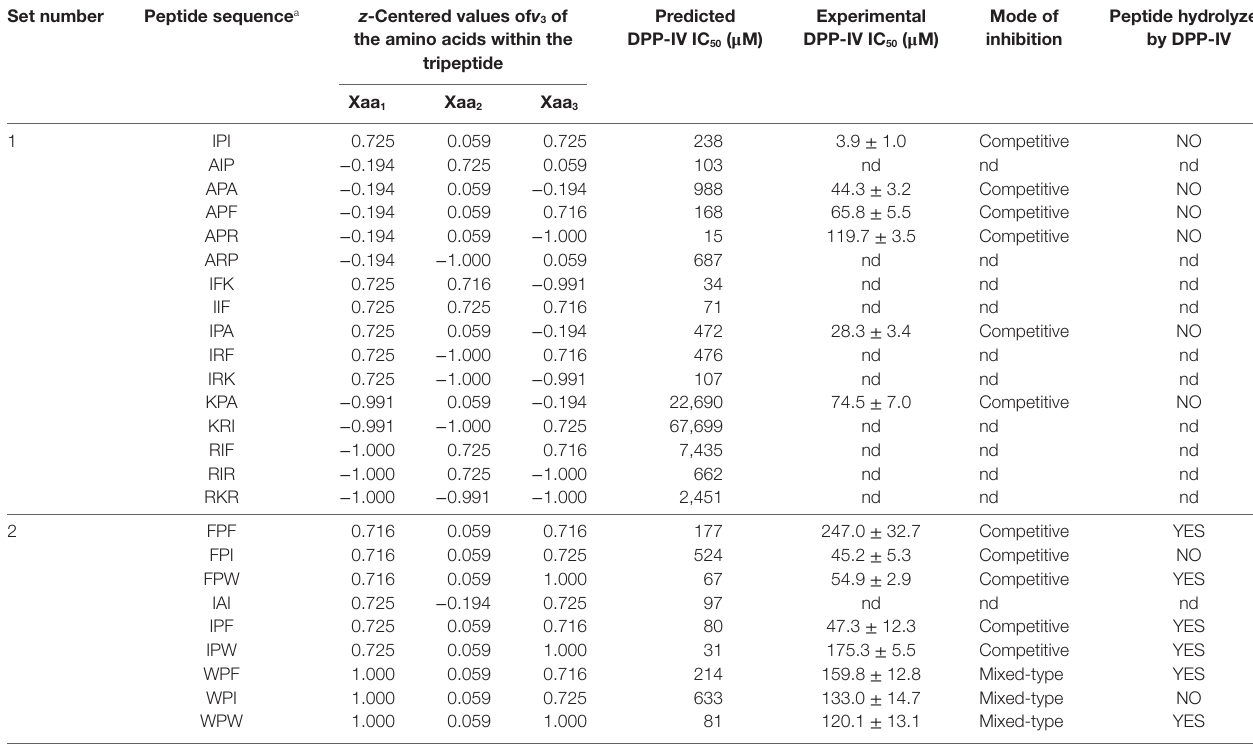
Table 2 | Dipeptidyl peptidase IV (DPP-IV) half maximal inhibitory concentration (IC 50 ), z -centered value of the hydrophobic parameter of side chains [ v 3 in the scale developed by Lin et al. (19)] of the amino acids constitutive of the peptides, and mode of inhibition of peptide analog of Ile-Pro-Ile. set number Peptide sequence